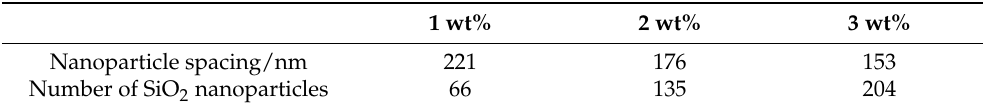
Figure 8. Nano-doping concentration is ( a ) 1 wt%, ( b ) 2 wt%, ( c ) 3 wt% epoxy resin/SiO 2 composite model. Table 7. The number and spacing of SiO 2 nanoparticles in the nano-dielectric models with different filling